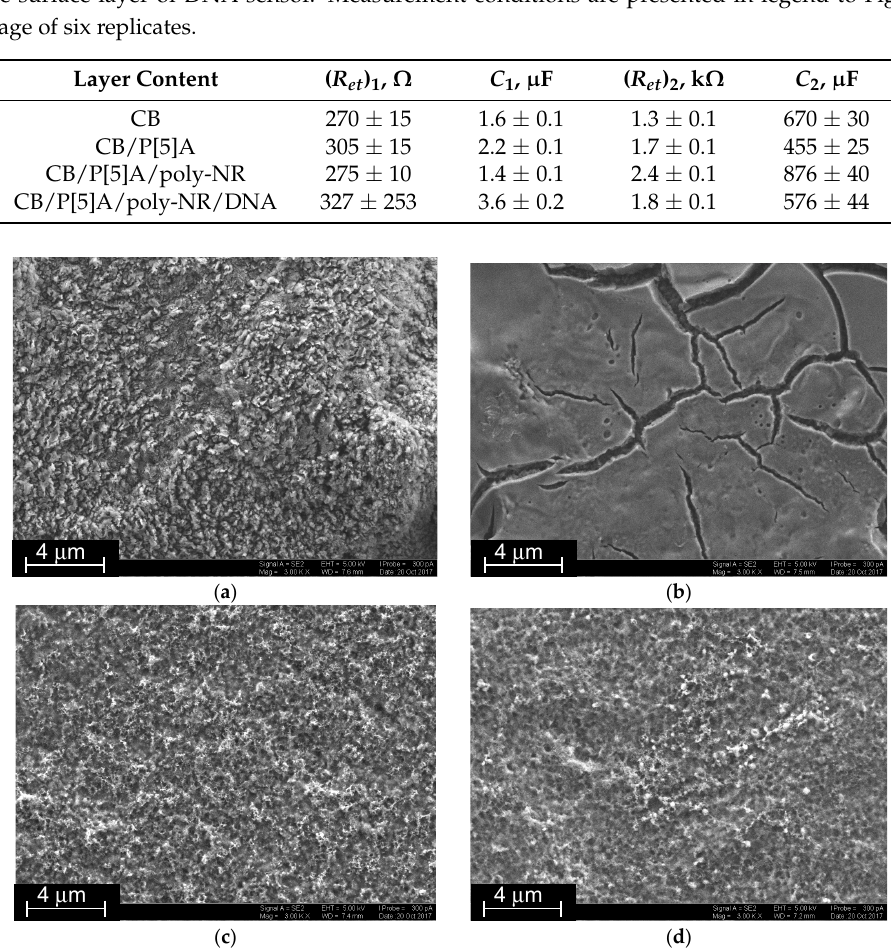
Figure 6. SEM images of glassy carbon covered with CB ( a ), that after P[5]A deposition ( b ), CB/P[5]A/poly-NR film ( c ) and that obtained in the presence of 0.2 mg/mL of DNA ( d ). Sensors 2018 , 18 , x FOR PEER REVIEW